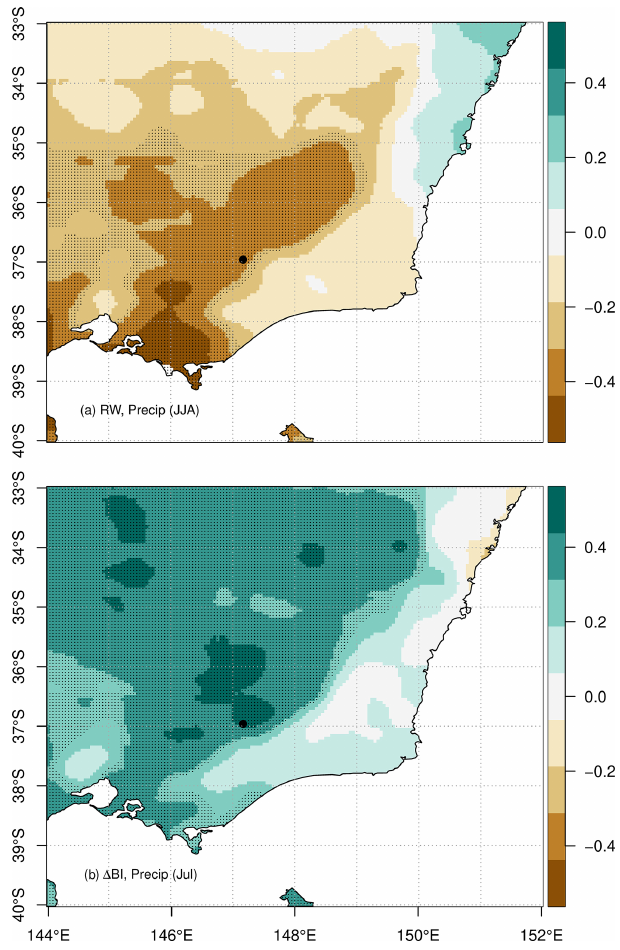
Figure 9. RW and (cid:49) BI chronology correlations with AGCD total monthly precipitation data for the 1929–1998 period. (a) RW corre- lation with mean June, July and August (winter) total precipitation; (b) (cid:49) BI correlation with total July precipitation. Shaded areas rep- resent statistically significant correlations ( p < 0 . 05), and the study site location is marked by the black